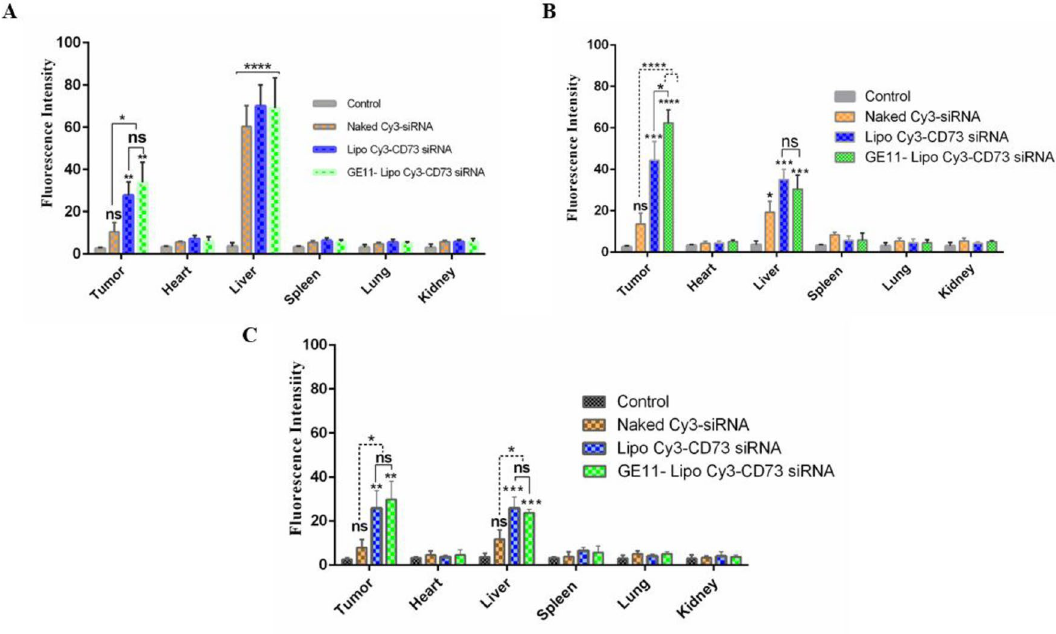
Figure 5. Tissue biodistribution of GE11-targeted, non-targeted liposomal formulation containing Cy3- siRNA, and Naked Cy3 siRNA at three-time intervals (4, 24 and 48 h post injection) in tumor site, heart, liver, spleen, lung, and kidney tissues. ( A ) Tissue biodistribution of different formulations at 4 h time interval. ( B ) Tissue biodistribution of different formulations at 244 h time interval. ( C ) Tissue biodistribution of different formulations at 48 h time interval. The intensity of Cy3 fluorescence dye indicates drug accumulation in different tissues. Data are expressed as mean ± standard deviation (n = 3). Statistically significant differences are represented as follows: * P < 0.05, ** P < 0.01, *** P < 0.001, **** P < 0.0001.